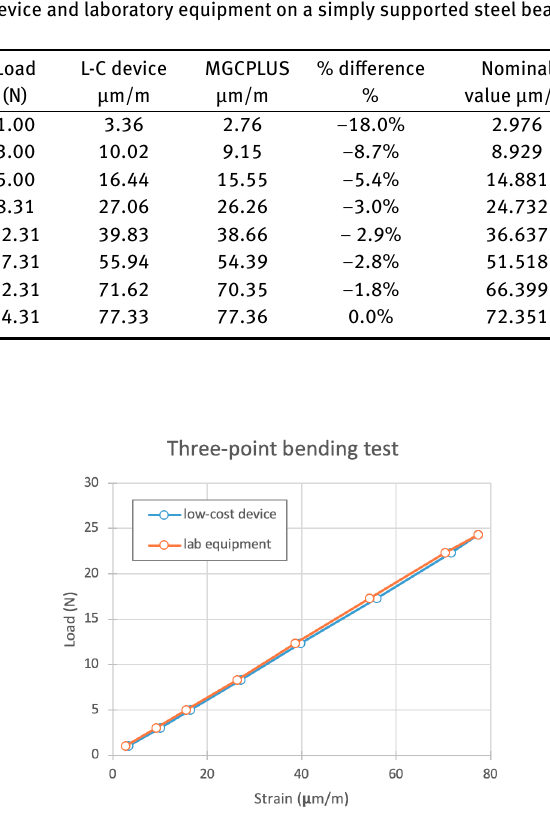
Figure 6: Comparison between the HBM MGCplus and low-cost device. Strain values for the simply supported steel beam with an increasing load applied at mid span